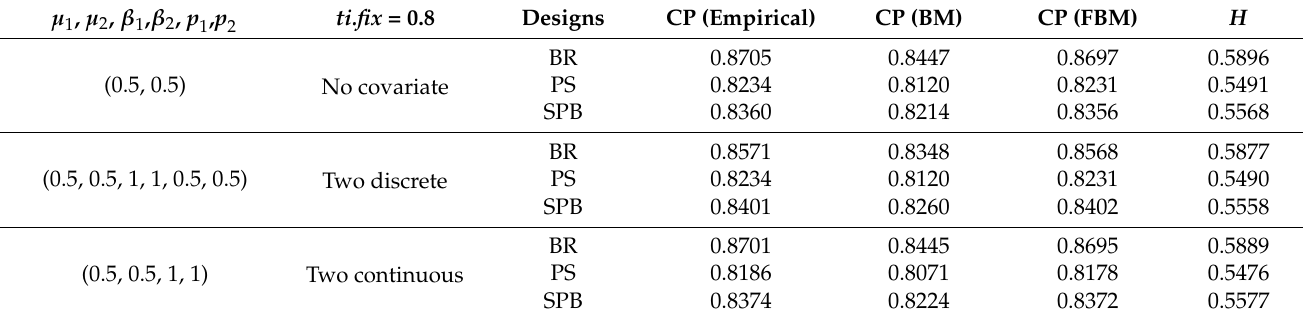
Table 7. CPs under misspecification scenarios: ε ’s ~increments of FBM, H = 0.9, drift = 1.5, ti.fix = 0.8. , p µ 1 , µ 2 , β 1 , β 2 , p 1